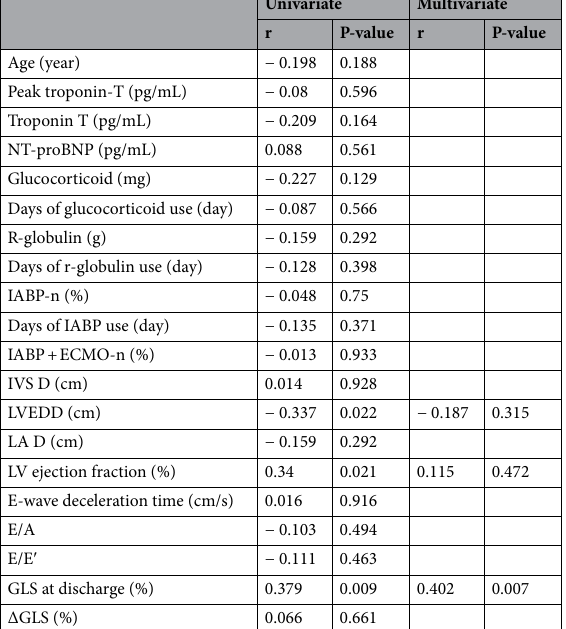
Table 2. Linear regression analysis for GLS of 2-year follow-up in FM. IABP intra-aortic balloon pump, ECMO extracorporeal membrane oxygenation, IVS interventricular septum, LVEDD end-diastolic dimensions, LA left atrium, EF ejection fraction, E peak early diastolic mitral flow velocity, A peak late diastolic mitral flow velocity, E ′ Spectral pulsed-wave Doppler-derived early diastolic velocity from the septal mitral annulus, GLS global longitudinal